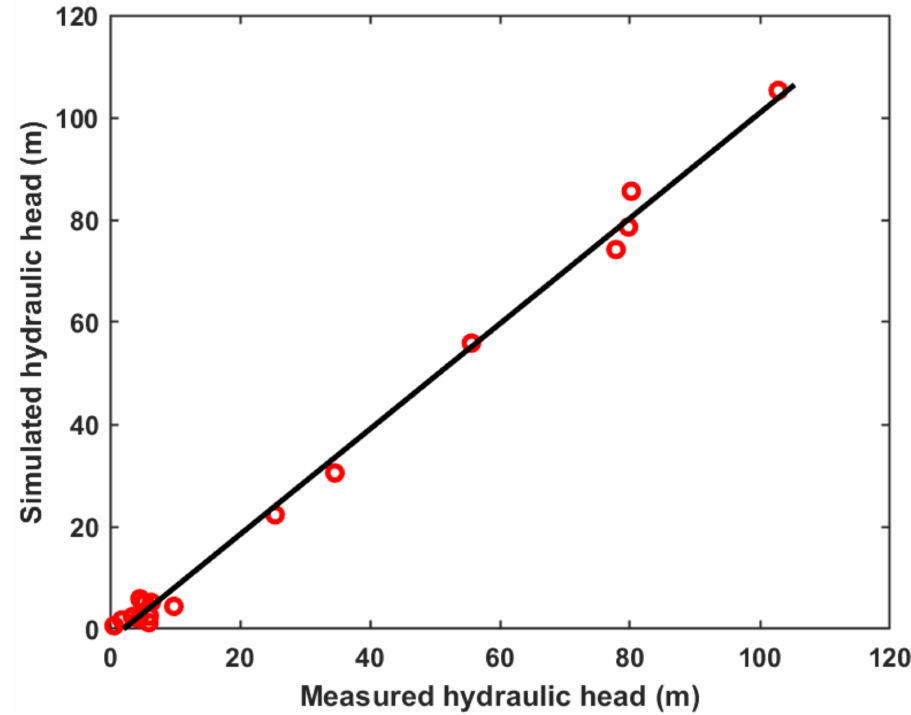
Figure 6. Comparison between simulated and observed steady-state hydraulic head after FEFLOW model